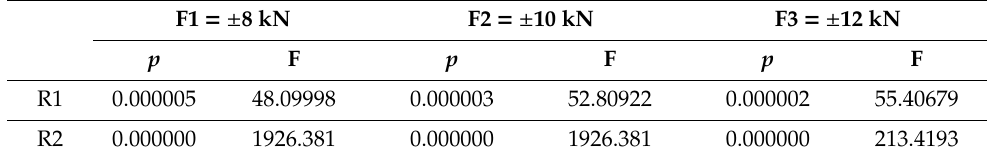
Table 10. The values of p and F respectively after processing the experimental data using